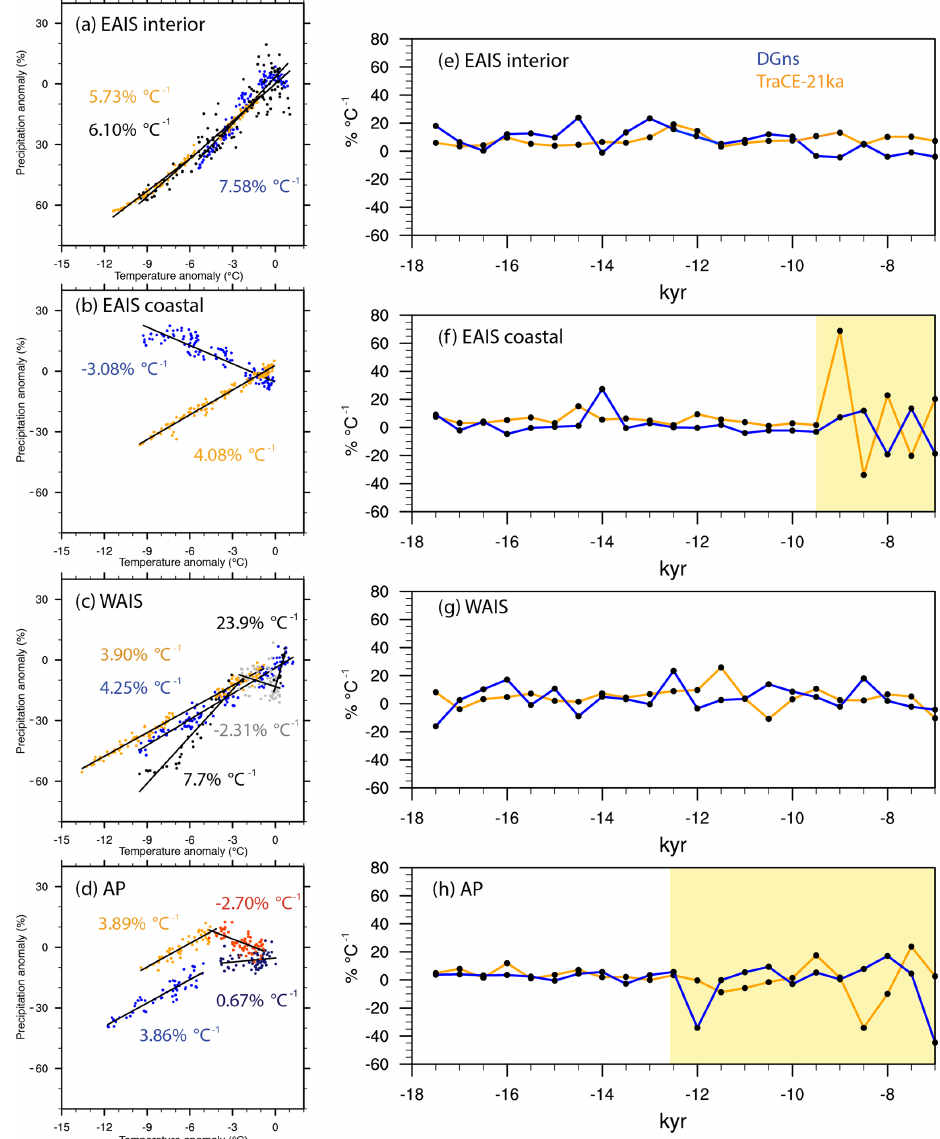
Figure 5. (a–d) Scaling relationships of accumulation (% relative to PI) and temperature ( ◦ C relative to PI) in each region. Black and grey dots refer to the proxy record, blue and purple dots refer to the DG ns simulation, and orange and red dots refer to the TraCE-21ka simulation. (e–h) The ratio of the change in precipitation (%) to the change in temperature ( ◦ C) per 500 years. The yellow bars in panels (f) and (h) indicate a shift to higher variability in accumulation–temperature scaling in the AP and EAIS coastal